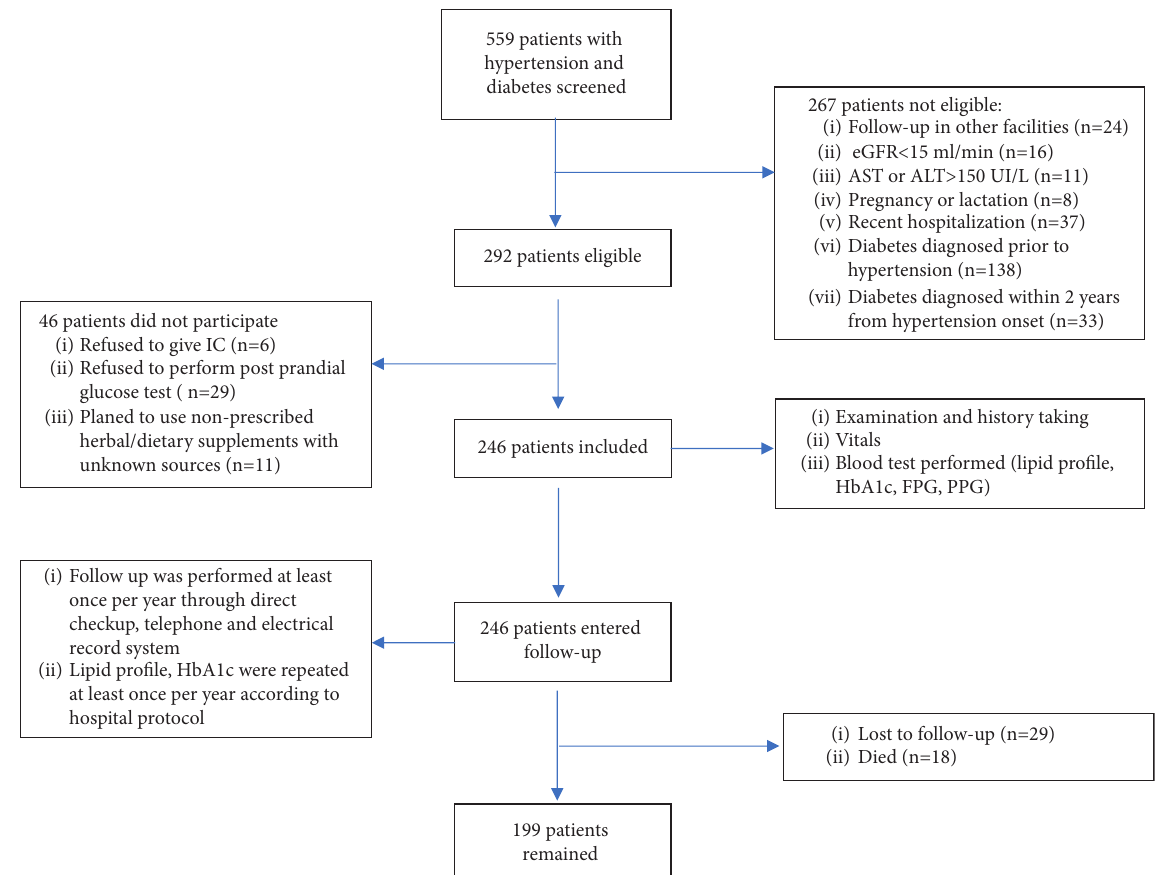
Figure 1: Flow diagram of the study procedure and patient selection. eGFR: estimated Glomerular Filtration Rate; ALT: alanine transaminase; AST: aspartate transaminase; IC: informed consent; PFG: fasting plasma glucose; PPG: postprandial plasma glucose; HbA1c: glycated